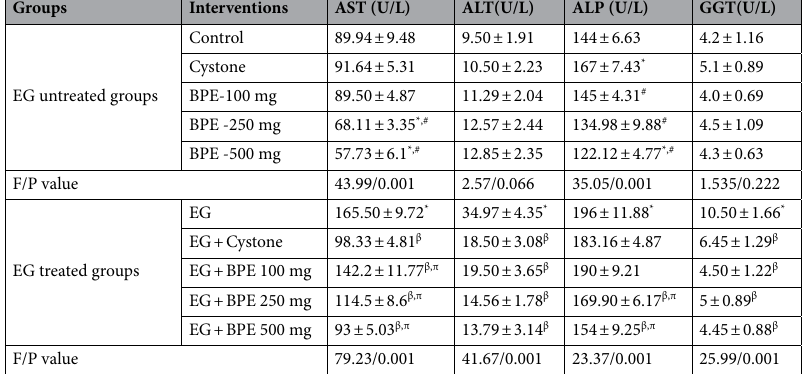
Table 3. Effect of the interventions on liver enzymes on day 30. * P < 0.05 compared to EG untreated-control group. # P < 0.05 compared to EG untreated-cystone group. β P < 0.05 compared to EG treated group. π P < 0.05 compared to EG treated-EG + cystone